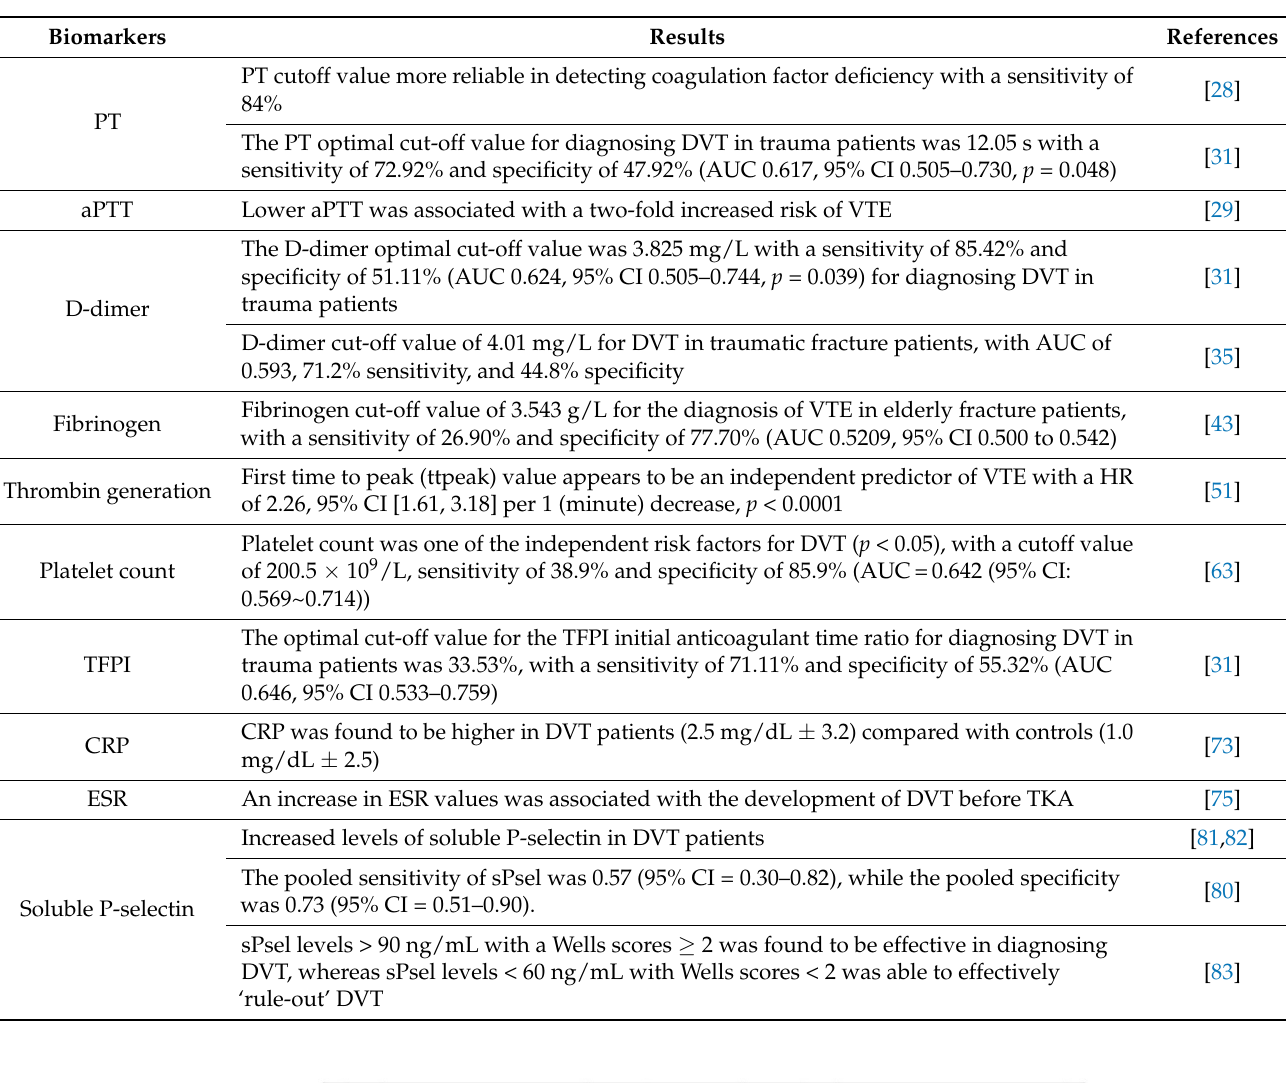
Table 1. Biomarker in predicting the risk of